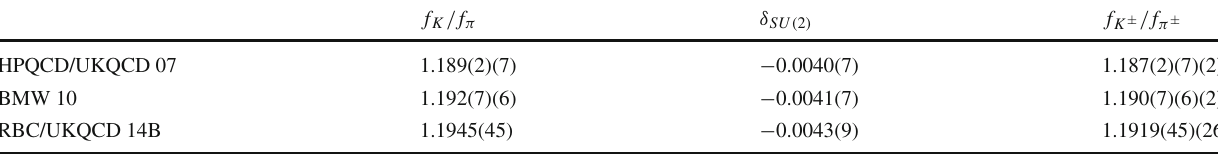
Table 17 Values of the SU ( 2 ) isospin-breaking correction δ SU ( 2 ) applied to the lattice data for f K / f π , entering the FLAG average at N f = 2 + 1, for obtaining the corrected charged ratio f K ± / f π ± . The last error in the last column is due to a 100% uncertainty assumed for δ SU ( 2 ) from SU ( 3 ) χ PT f K / f